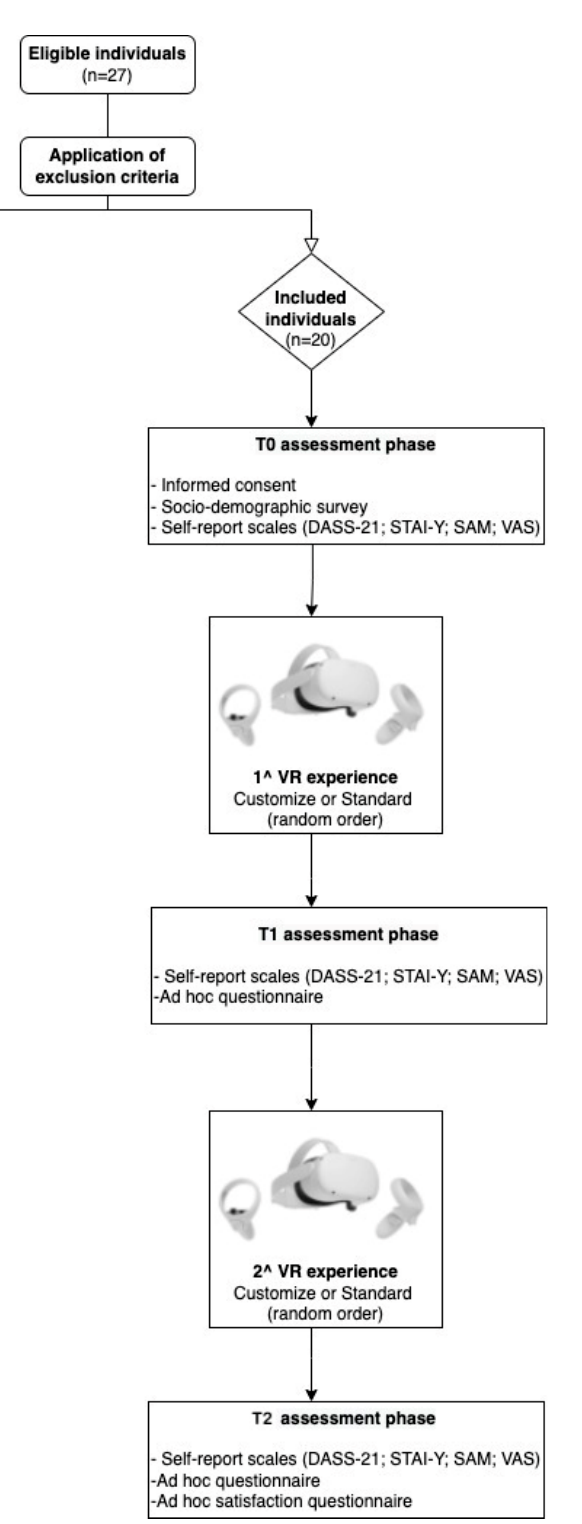
Figure 2. Flowchart procedure. Notes: DASS-21 = Depression, Anxiety and Stress Scale-21; STAI-Y = State-Trait Anxiety Inventory-Y1 and Y2; SAM = Self-Assessment Manikin; VAS = Visual Ana- logue Scale.